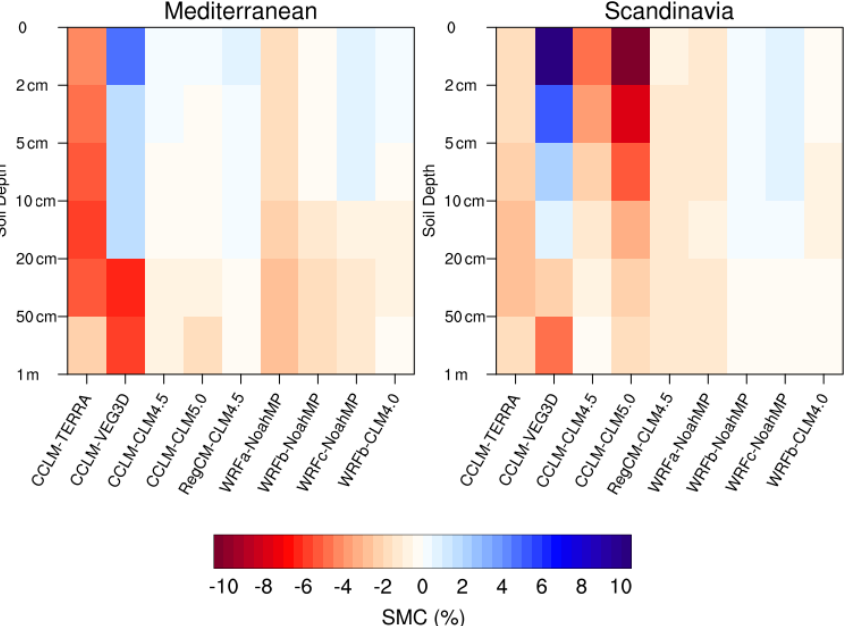
Figure 9. Mean summer changes in soil moisture content (SMC) due to afforestation (FOREST minus GRASS) in the top 1m of the soil over the Mediterranean and Scandinavia. Positive (negative) values indicate an increase (decrease) due to afforestation.